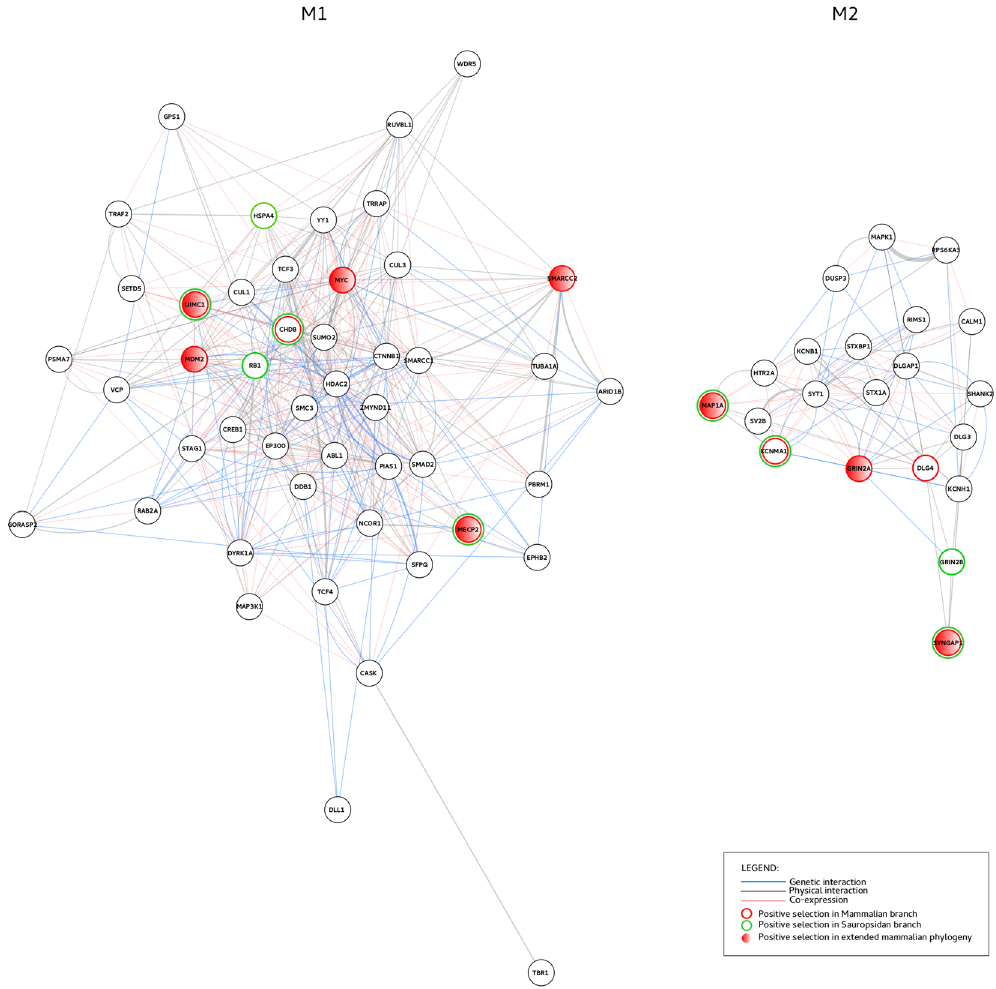
Figure 1. M1 and M2 gene networks. Interaction networks of module 1 (M1) an module 2 (M2) genes as obtained by Cytoscape, using the geneMANIA